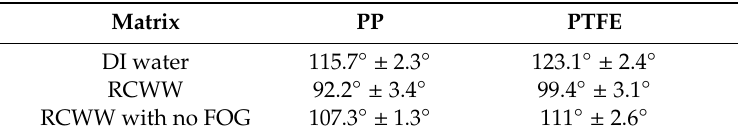
Table 1. CA values obtained for PP and PTFE membranes using di ff erent